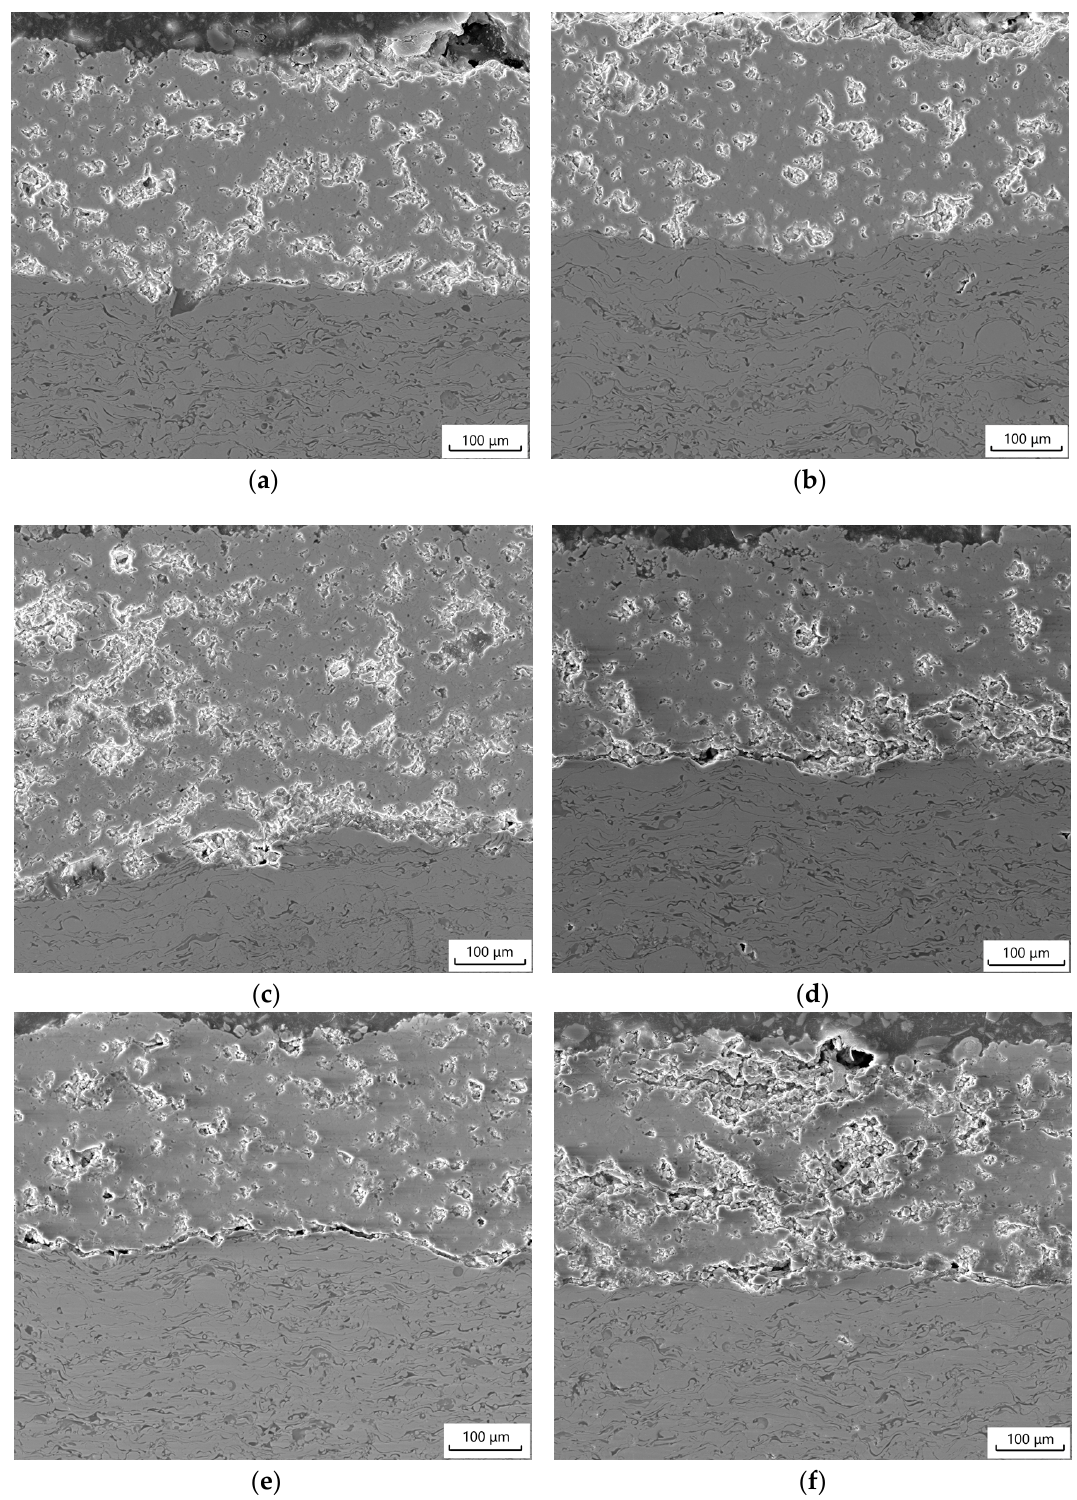
Figure 12. The cross-section morphology ofthe top coats in TBCs with 10% pore former added at 1100 °C for different